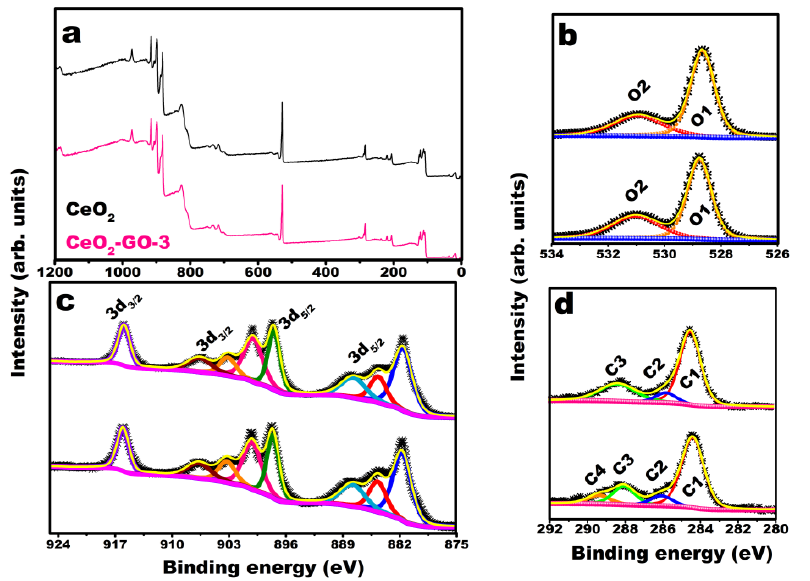
Figure 2. XPS analysis of the CeO 2 ( top view ) and CeO 2 –GO-3 ( bottom view ) electrocatalysts: ( a ) survey scans, ( b ) O 1s, ( c ) Ce 3d, and ( d ) C 1s.